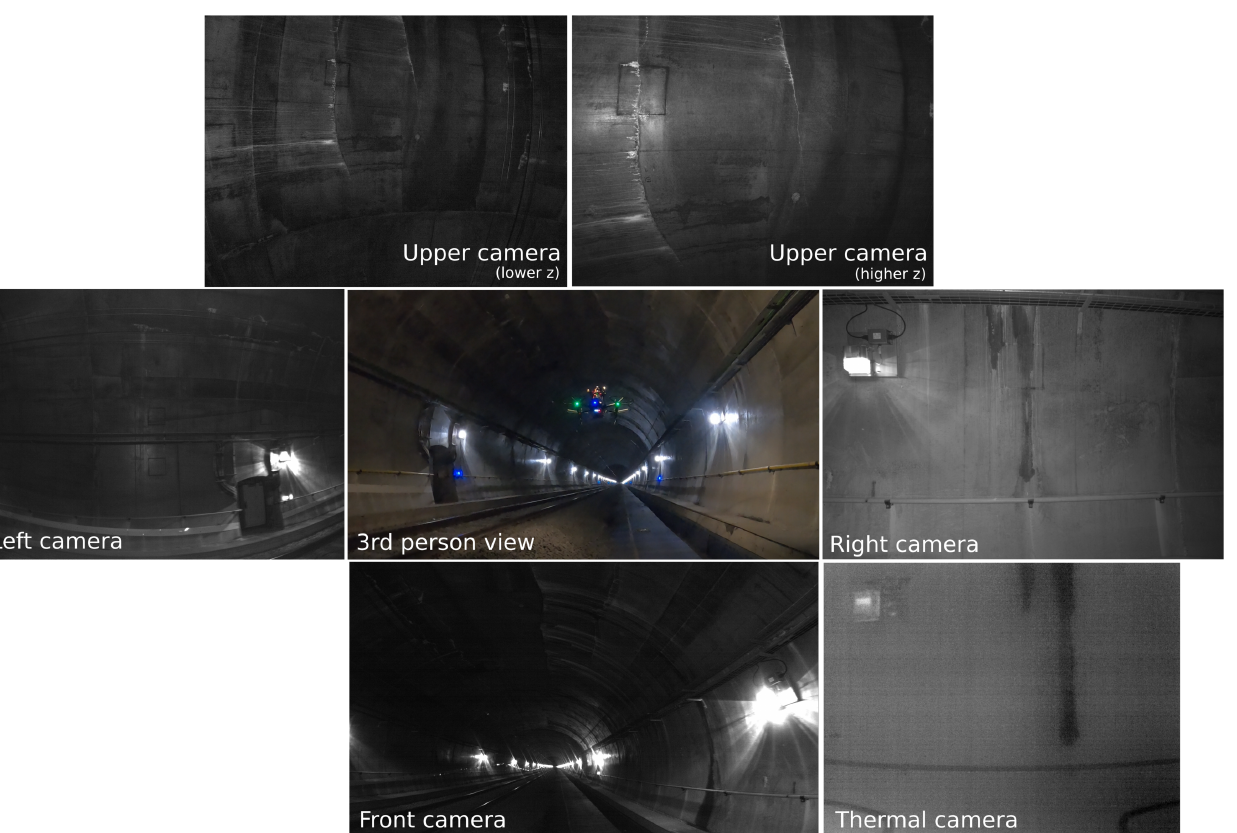
Figure 12. Example of images captured by all the inspection payload sensors together with a 3rd- person view of the aerial platform flying inside the railway tunnel.